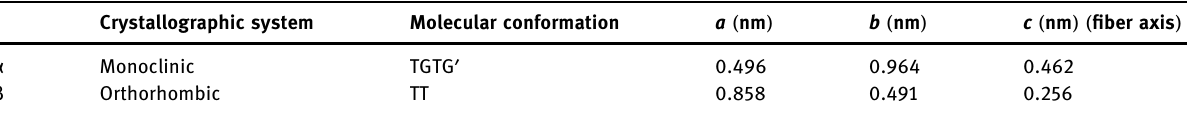
Table 1: Parameters of α - and β - polymorphs unit cells [ 16,17 ]